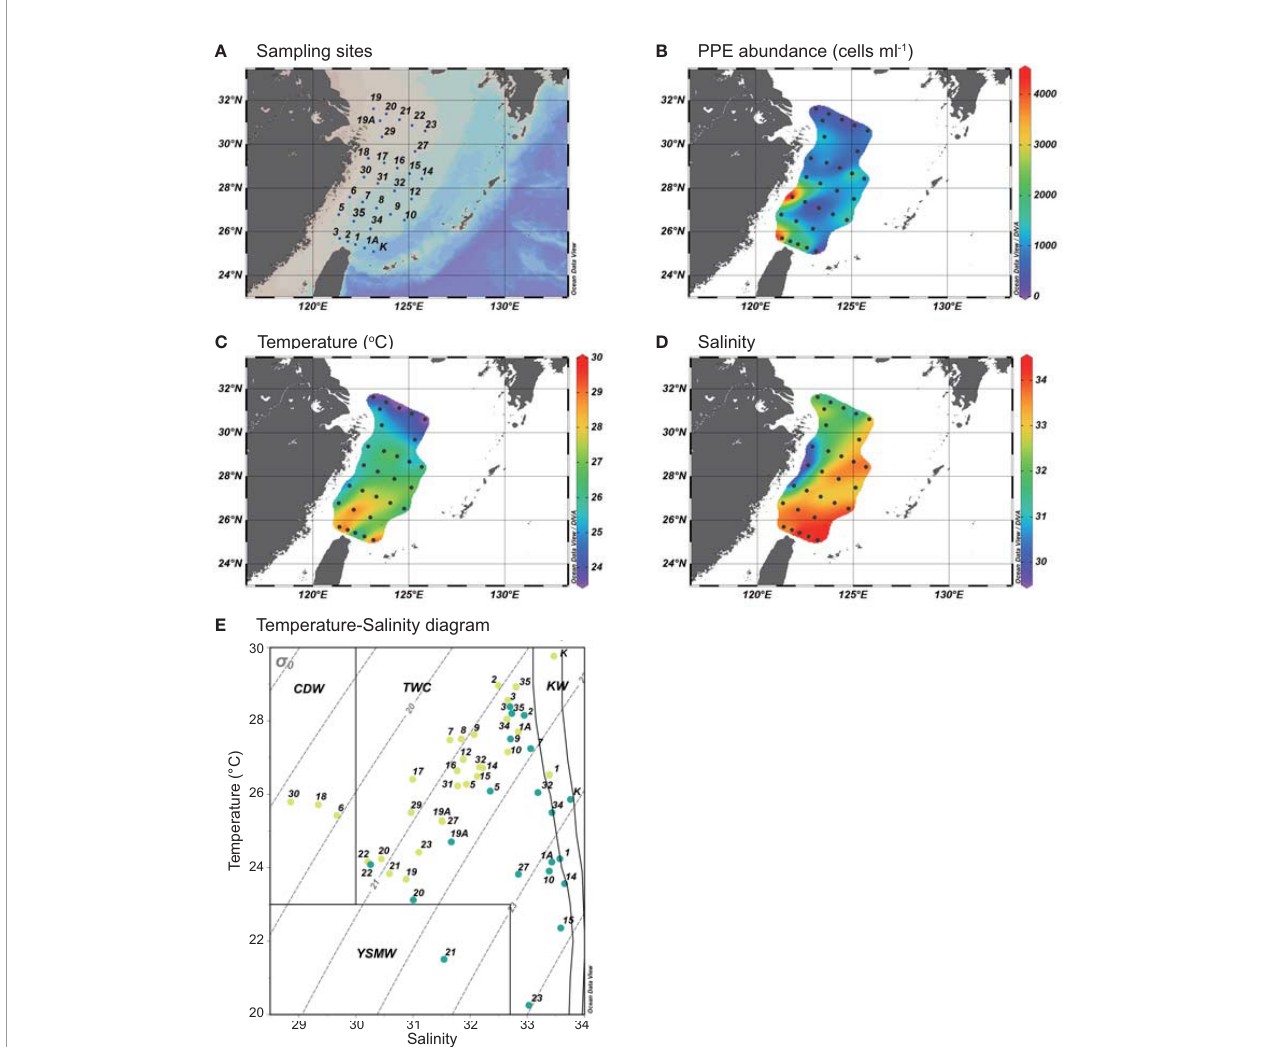
FIGURE 1 | (A) Maps show the sampling stations. (B) The distribution of photosynthetic picoeukaryotes (PPEs, cells ml -1 ) (C) temperature (°C) and (D) salinity of surface water during July, 2019. (E) The Temperature-Salinity (T-S) diagram shows the water types as de fi ned by Gong et al., 1996. The yellow and turquoise circles represent the surface water and DCM water, respectively. Dotted lines represent density (kg m -3 ). CDW, Changjiang Diluted Water; KW, Kuroshio Water; TWC, Taiwan Warm Current; YSMW, Yellow Sea Mixed